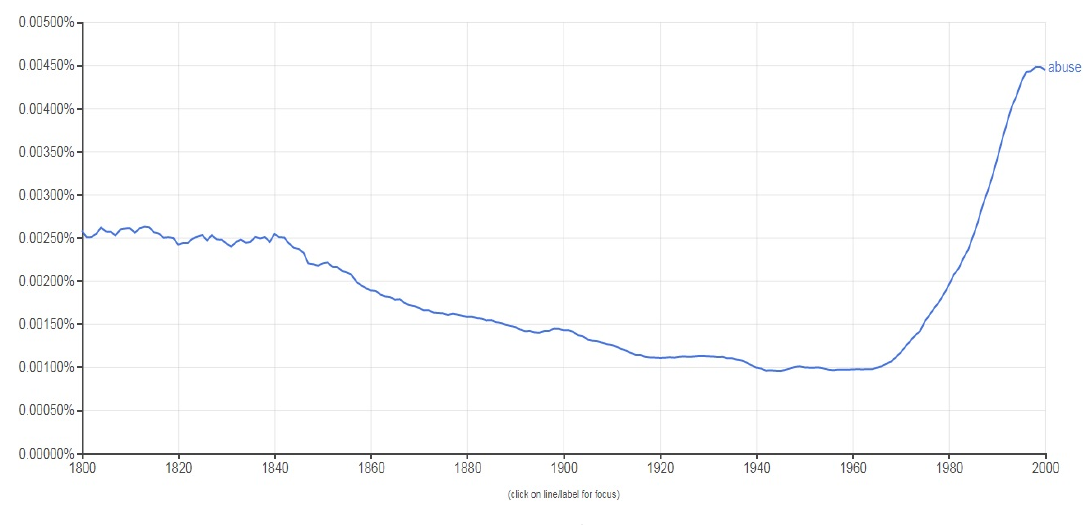
Figure 2. Figure 2. Abuse.